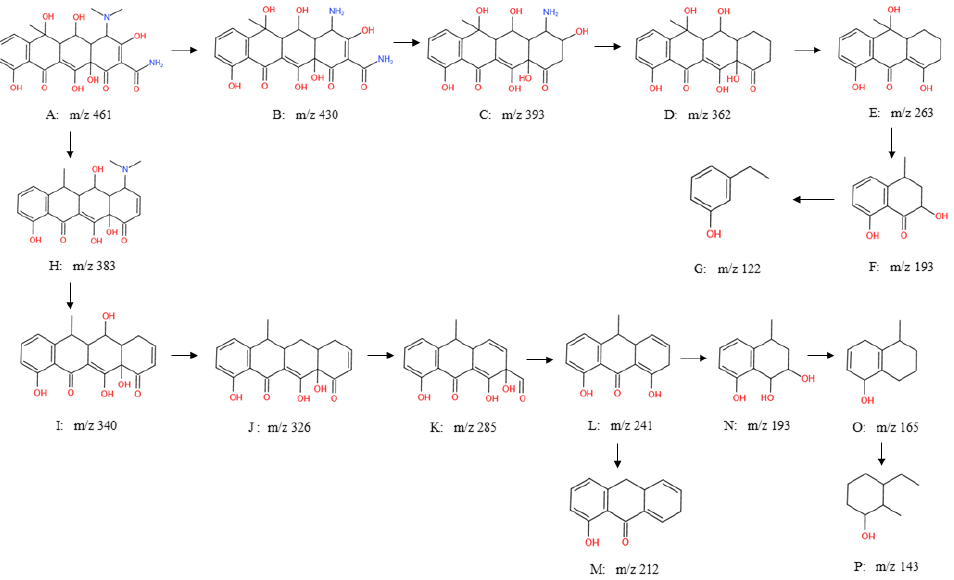
Figure 12. Degradation pathway of OTC. As shown in Figure 12, there are two main degradation paths. One path is: the generation of “B” is due to the loss of two N-methyl groups over the OTC. “C” is then formed by the removal of the amide group, based on which the absence of hydroxyl and amino groups is converted into “D,” and “E” is generated through ring-opening reactions, dihydroxylation reactions, and the removal of an acetyl group. The formation of “F”